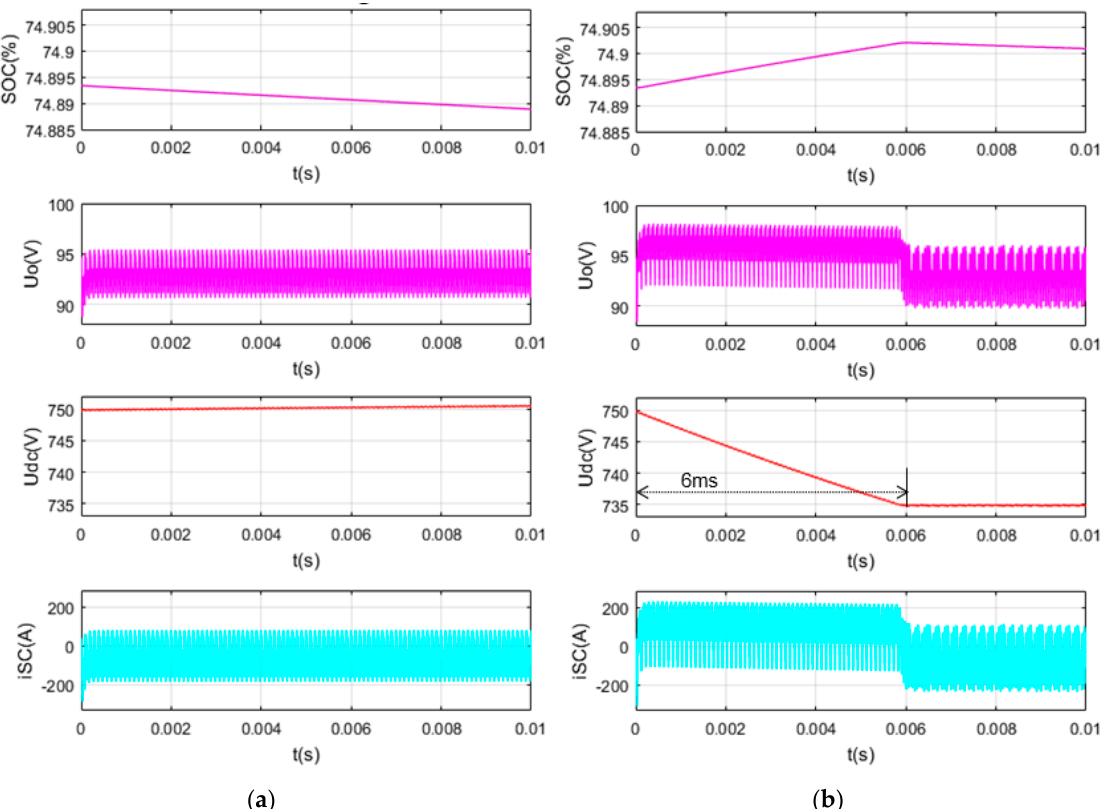
Figure 13. Experimental waveform diagram when the initial voltage, U dc , is 749.7 V and the initial voltage, U o , is 94 V: ( a ) MPC only for the DAB; ( b ) MPC for the DAB-SC system.